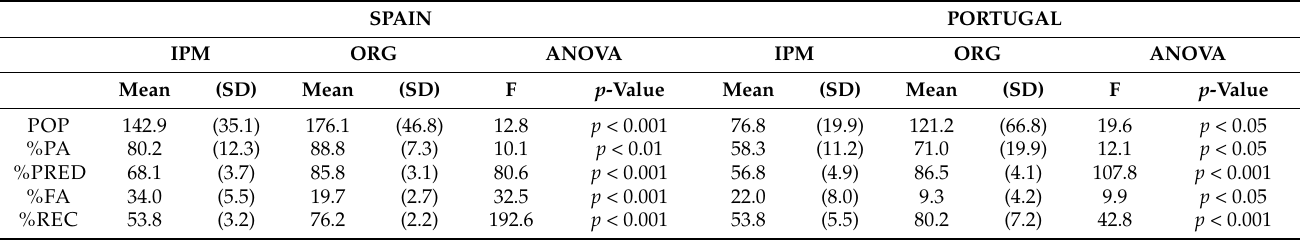
Table 3. Mean values and standard deviation rates of the Population Index (POP), Potential Attack (%PA), oophagous predation (%PRED), Final Attack (%FA) and Fruit Recovery (%REC) in the organic and IPM olive groves selected in Spain and Portugal (last sampling date). The level of statistical significance (ANOVA) is also